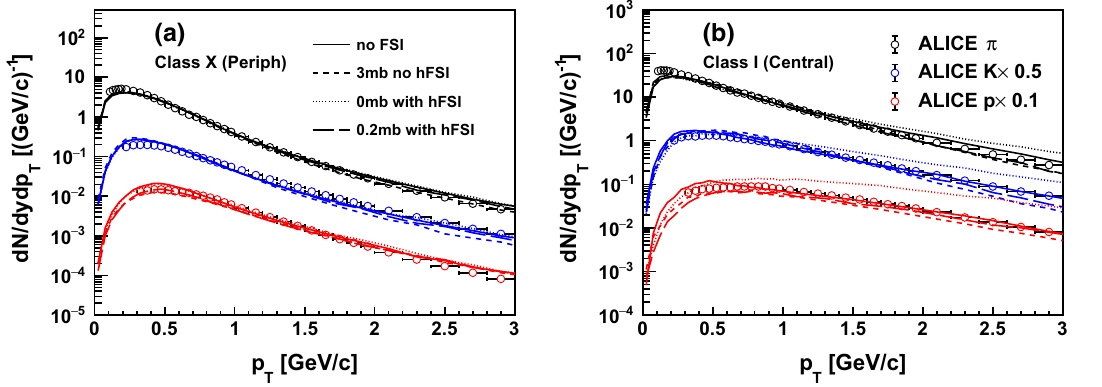
Fig. 7 Transverse momentum spectra within | y | < 0 . 5 for π (black), K (blue) and proton (red) in event class X for peripheral collisions (left) and event class I for central collisions (right) with no final state inter-